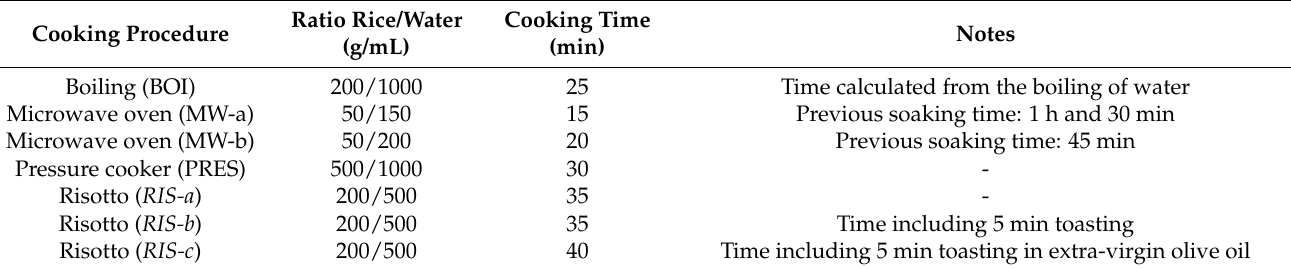
Table 1. Cooking conditions applied in the